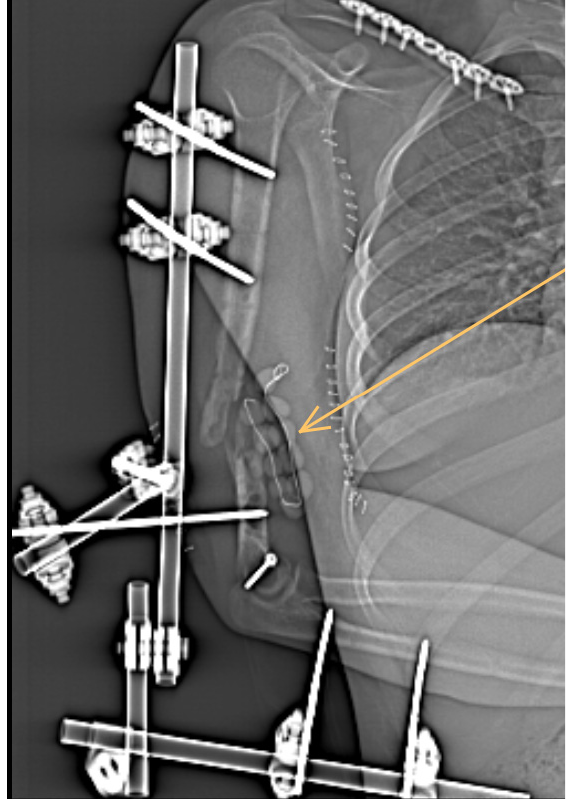
Figure 2. The fracture was then stabilized by an external fixation and the affected area was filled with gentamicin polymethylmethacrylate beads (indicated by arrow).